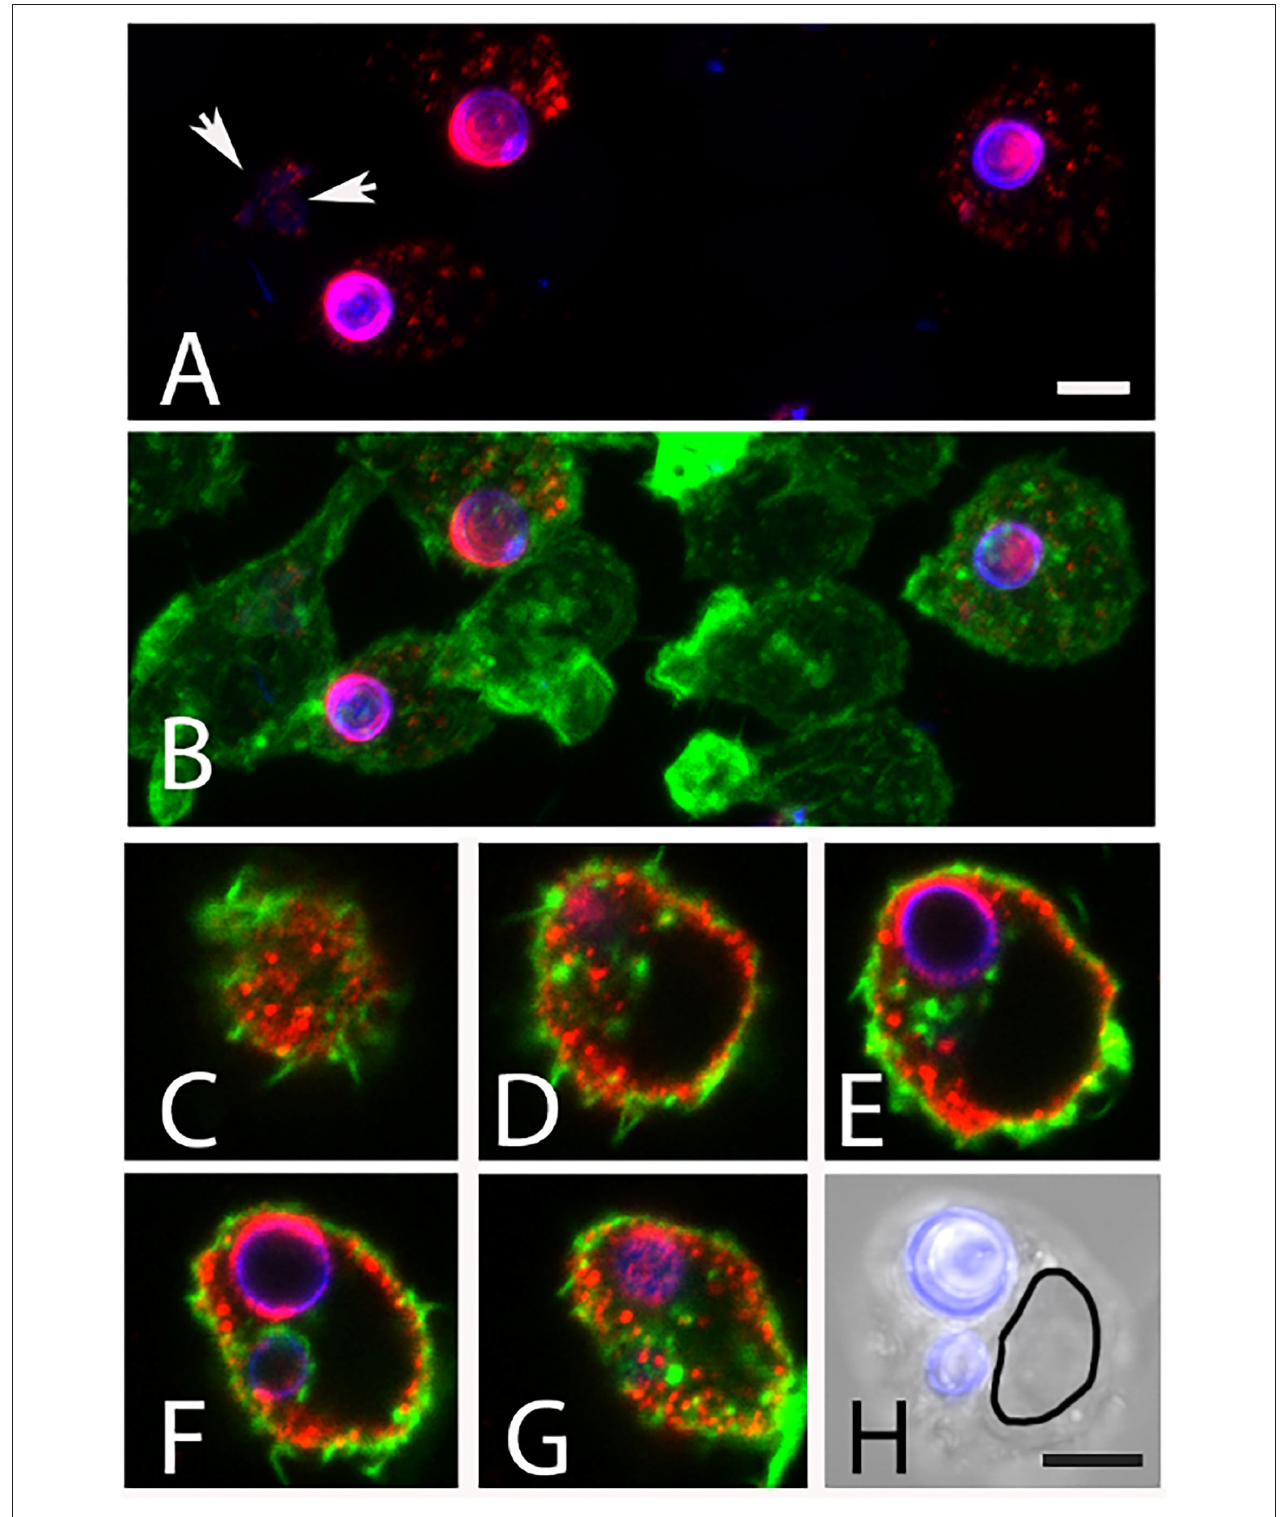
FIGURE 10 | Release of galactomannan from internalized AC. The J774 macrophage cells are visualized using phalloidin-FITC (green). The AC were stained with Calcofluor white (blue) and mab L10-1 (red). (A,B) show maximum intensity projections of J774 macrophages after 5h of co-incubation with AC. Released galactomannan is detectable in the infected cells. The arrow indicates galactomannan in a neighboring, non-infected cell. (C–G) represent single optical planes of an infected cell after 6h. The planes have a distance in Z of 2.8 µ m. (H) shows an overlay of a brightfield image and the Calcofluor white staining of the same cell. The outline of the nucleus is indicated in (H) . The bars in (A,H) represent 5 µ m and are valid for [ (A–H) , respectively].